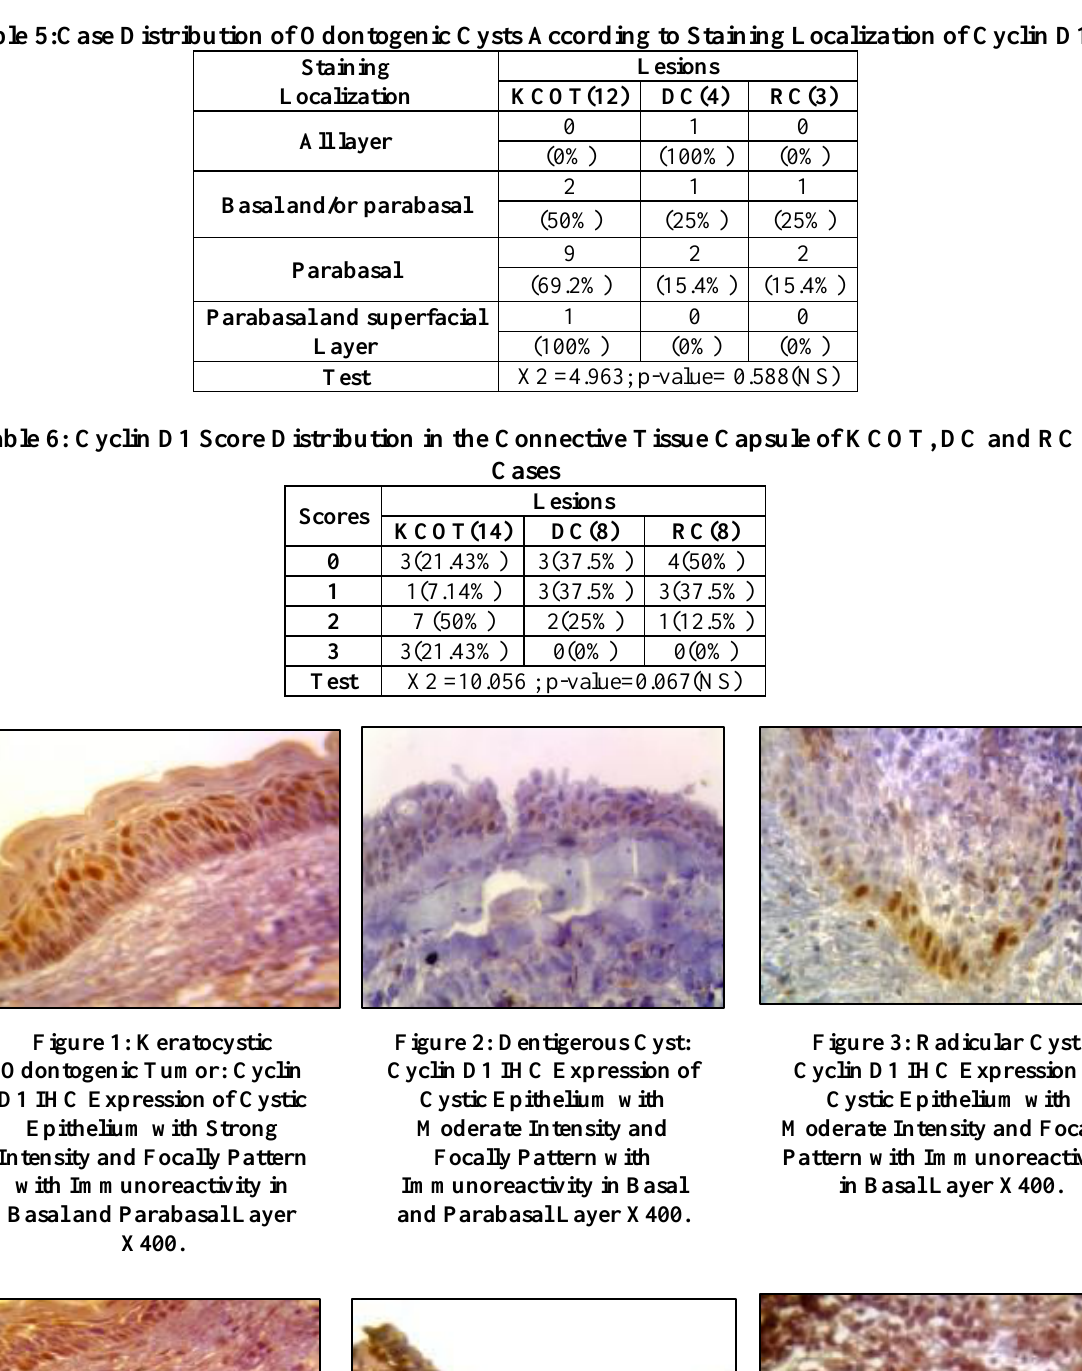
Figure 5: Dentigerous Cyst: Cyclin D1 IHC Expression of the Connective Tissue Capsule X400.